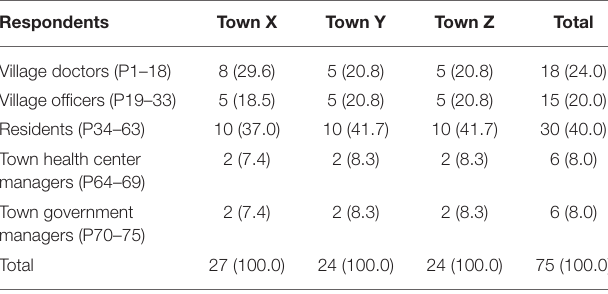
TABLE 1 | Selection of respondents for interviews (%).